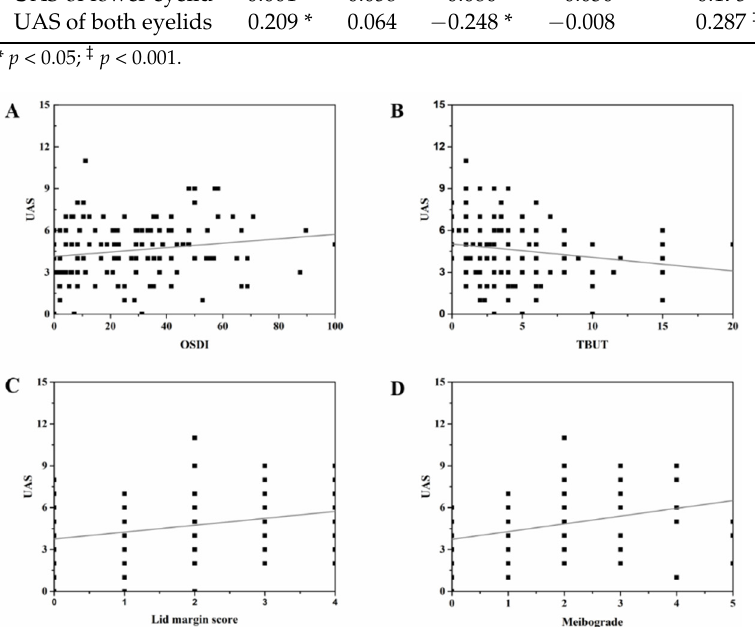
Figure 4. Correlations between UAS and OSDI, TBUT, Meibograde, and Lid margin score. ( A ) showed the correlation between UAS and OSDI, ( B ) showed the correlation between UAS and TBUT, ( C ) showed the correlation between UAS and Meibograde, and ( D ) showed the correlation between UAS and Lid margin score.